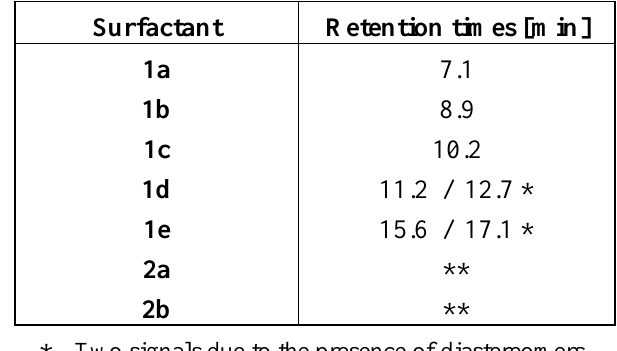
Table 2. Retention times of the different surfactants using MDPI, 4